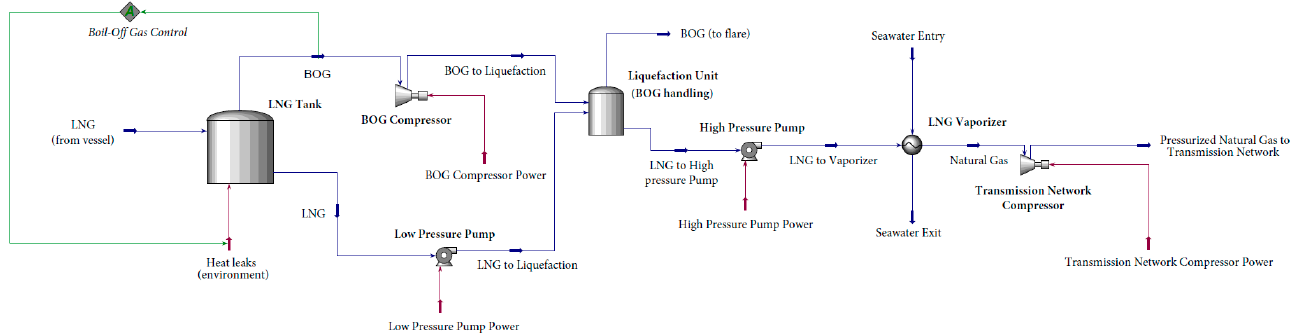
Figure 4. Simulated PFD for LNG regasification conventional process.